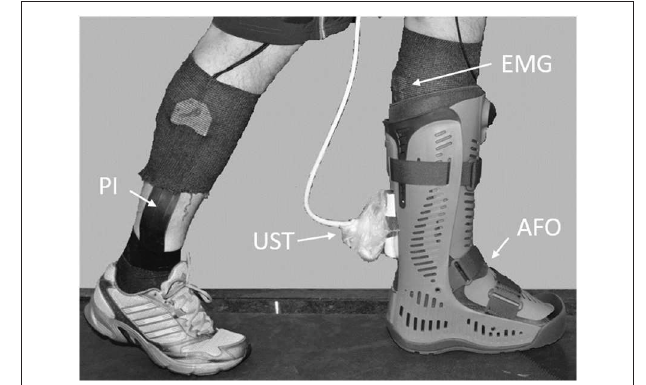
FIGURE 1 | Experimental set up. EMG, emg electrodes; UST, ultrasound transducer; PI, pressure insole; AFO, rigid ankle foot orthosis.